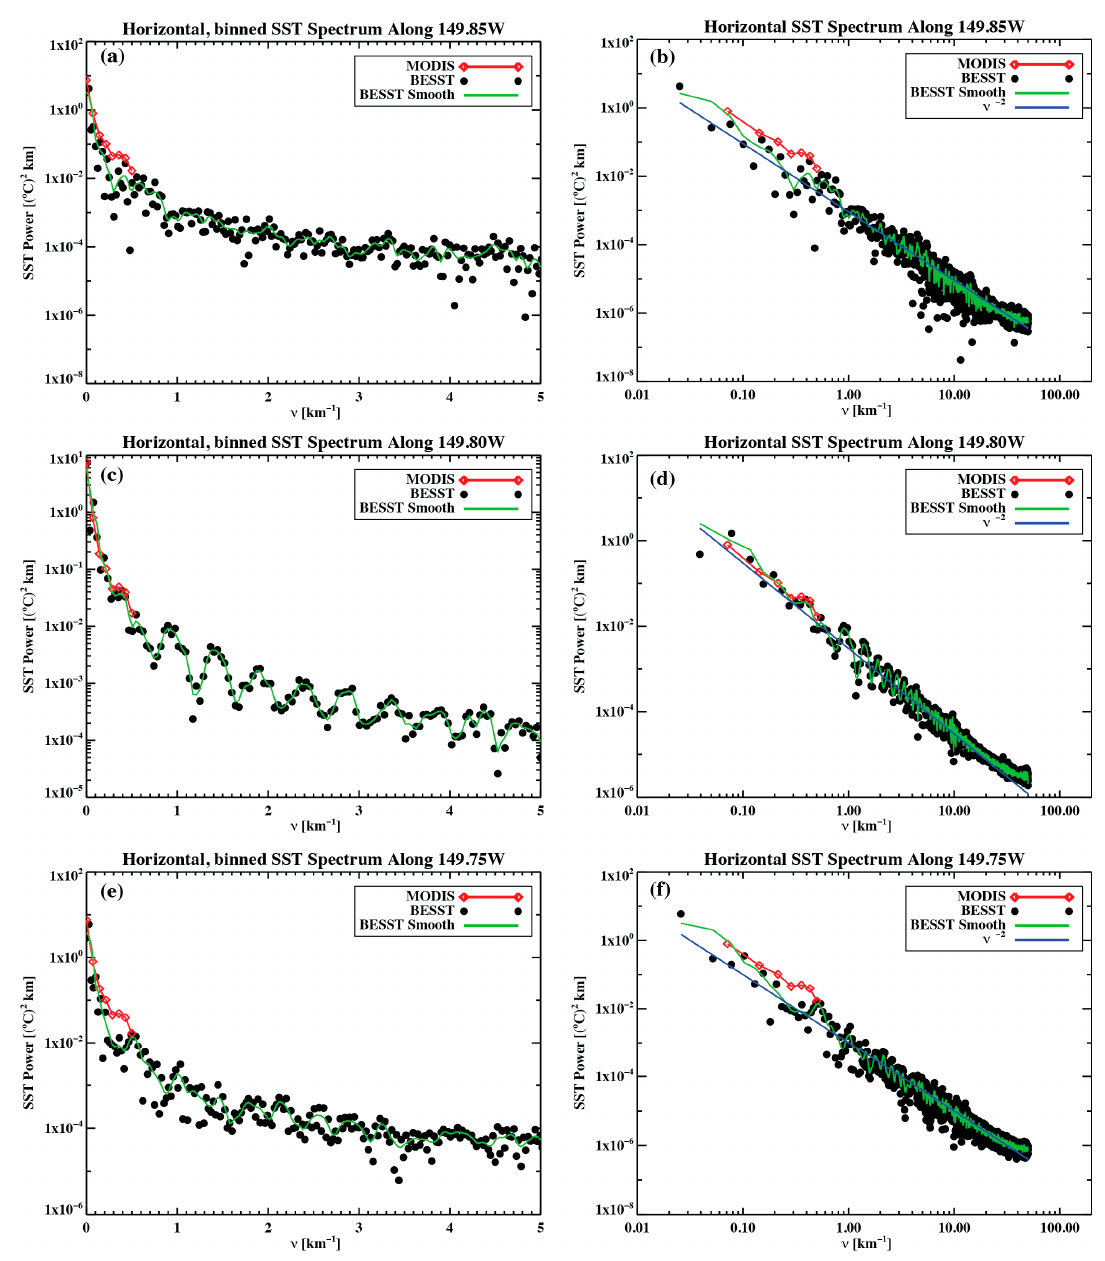
Figure 8. ( a – f ) Horizontal wavenumber spectra for SST variance from BESST, along the semi-log (left) and log–log axis (right), and along meridional transects: 149.85°W, 149.80°W, and 149.75°W. For a blended BESST horizontal wavenumber spectrum representative of the whole survey area,